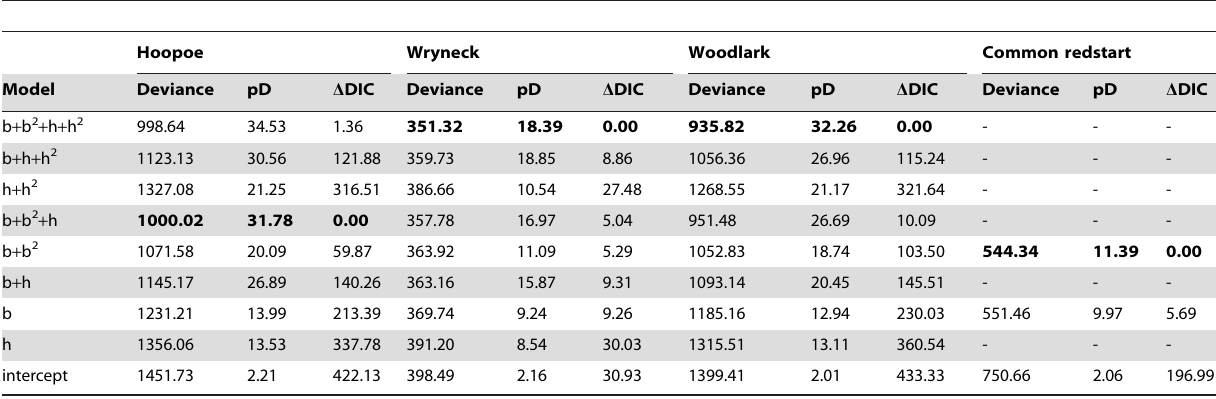
Table 1. Model selection results for the effect of the proportion of bare ground (b), its square (b 2 ), the vegetation height (h) and its square (h 2 ) on the foraging selection probability for the four bird species.